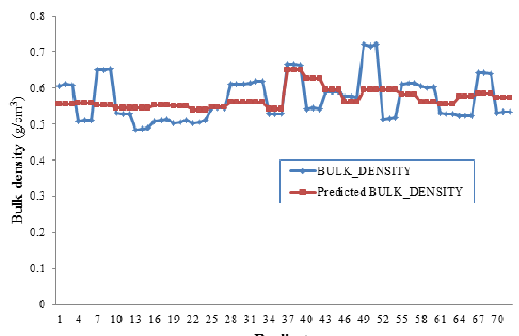
Fig. 3. Comparison of the observed and predicted bulk density of okra Process optimization